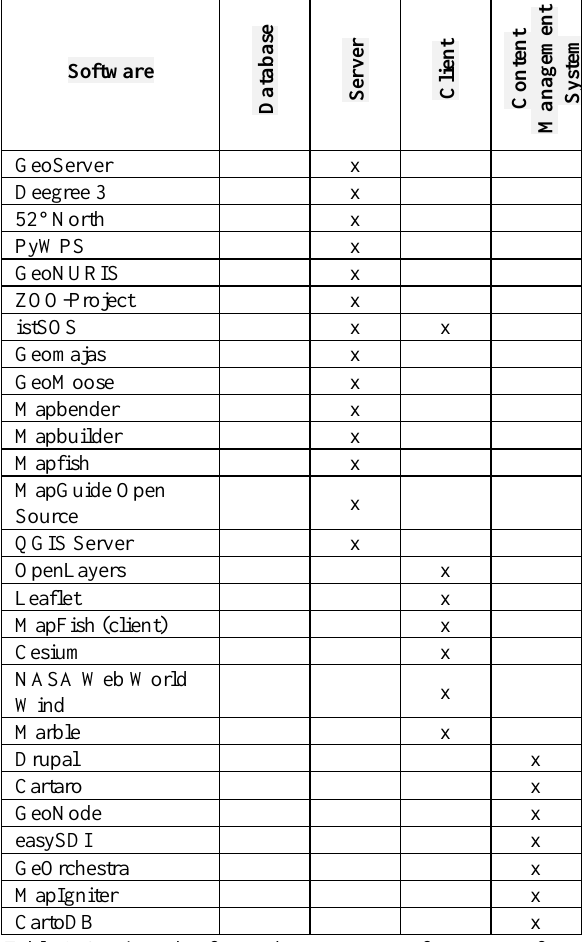
Table 1. Cutting-edge free and open source software to perform the role of the components in a Web mapping